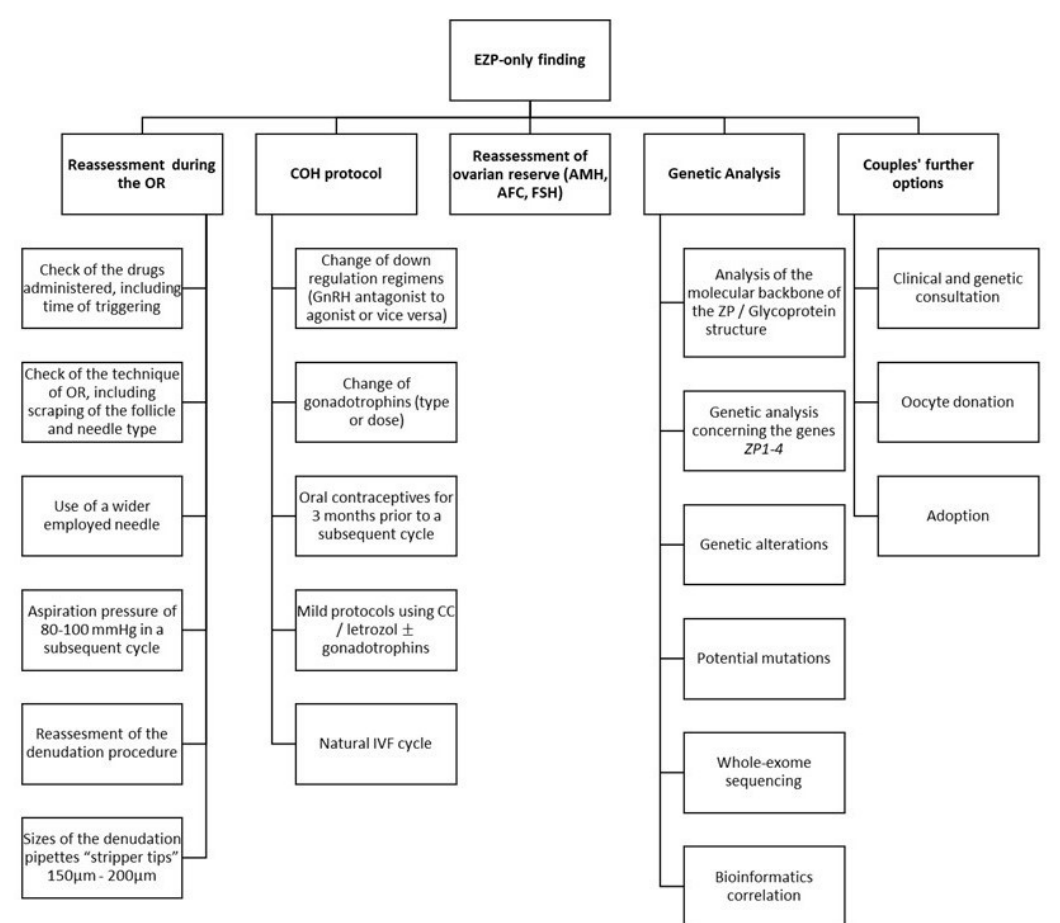
Figure 1. Summary of recommendations for the management of patients presenting with the empty zona pellucida (EZP)—only finding. Abbreviations: EZP, empty zona pellucida; OR, oocyte retrieval; COH, controlled ovarian hyperstimulation; GnRH, gonadotropin-releasing hormone; CC, clomiphene citrate; IVF, in vitro fertilization; AMH, anti-Mullerian hormone; AFC, antral follicle count; FSH, follicle stimulating hormone; ZP, zona pellucida.